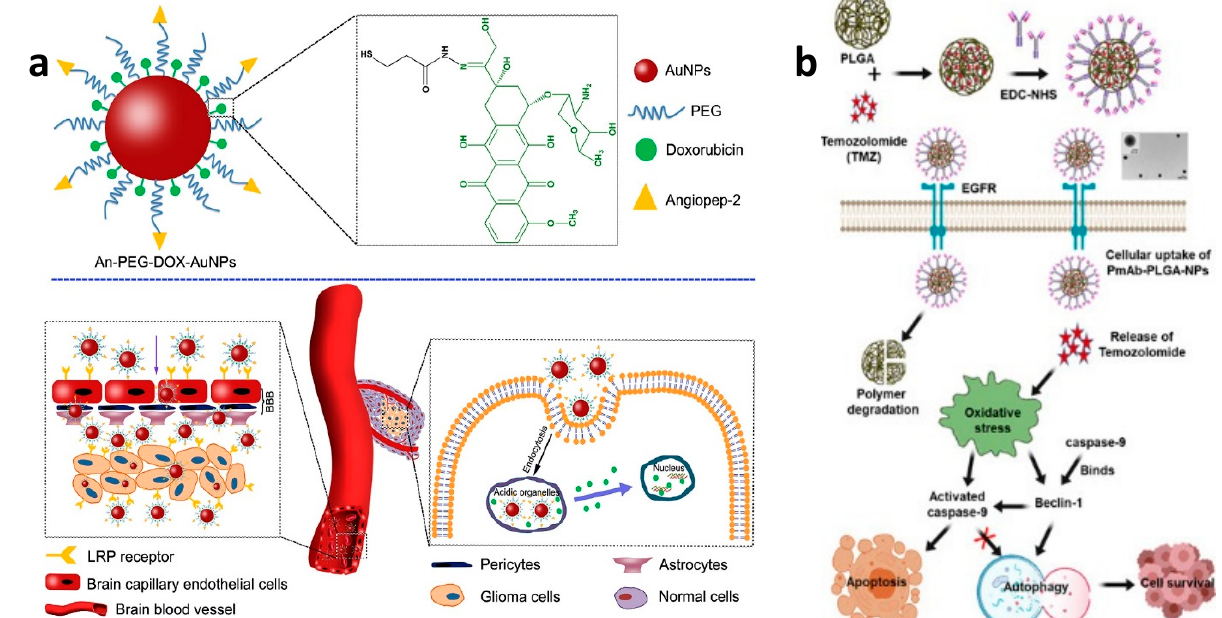
Figure 10. Interpretation of the drug-nanoparticle complex formation in (a) An-PEG-DOX AuNPs [133] and (b) PmAb-TMZ-PLGA-NPs [181]. Adapted with permission from Refs. [133,181]. Copyright 2015 Elsevier and 2020 American Chemical Society.